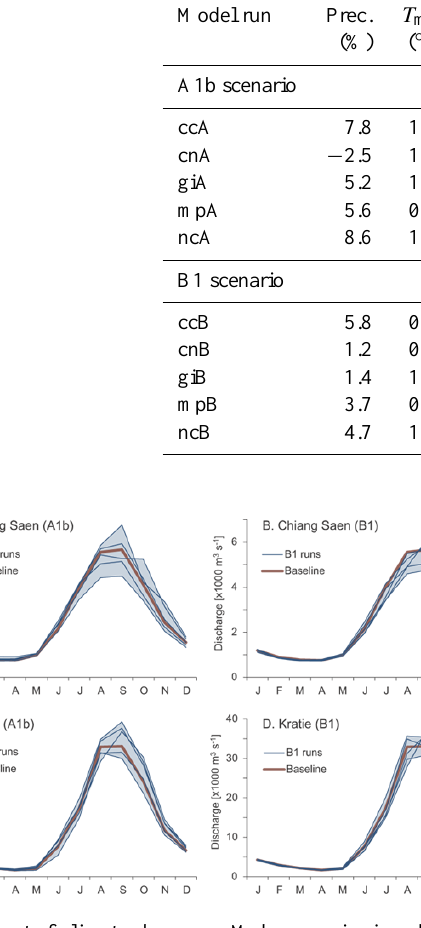
Fig. 5. Impact of reservoir operations on Mekong main river dis- charge. Monthly average baseline discharges (1982–1992) are com- pared with the discharge altered by reservoir operation at: (A) Chi- ang Saen; (B) Vientiane; (C) Pakse; and (D) Kratie. See Fig. 1c for the location of the stations. See Tables S4 and S5 in the Supplement for tabulated data. Note the differing discharge scales.